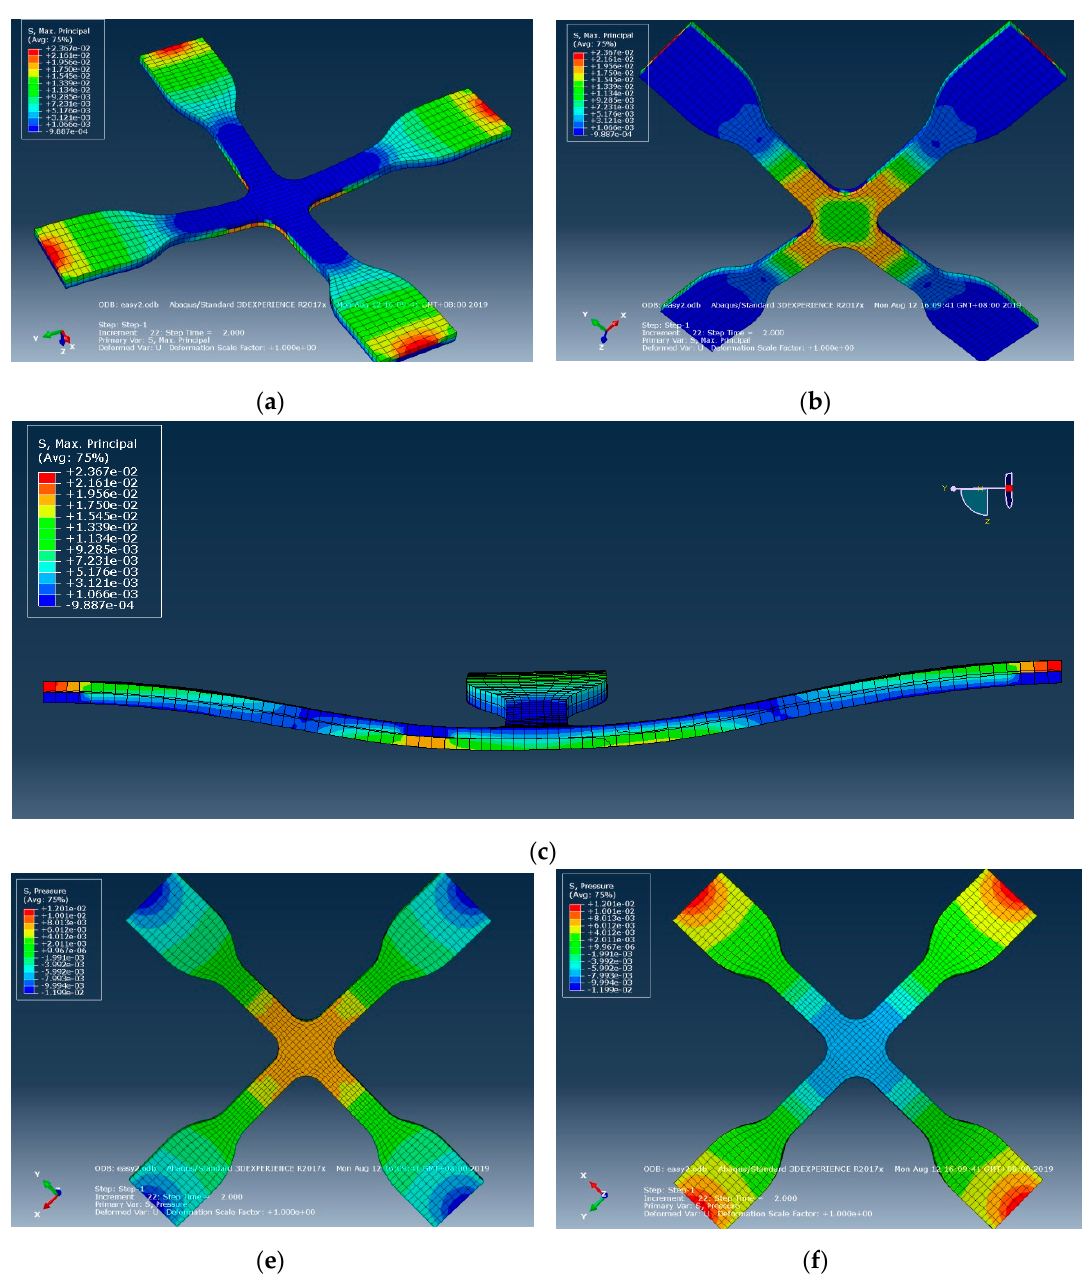
Figure 8. Simulation of force distribution before and after gasbag pressure on cross mold contact stress surface, microstructure surface, and cross section controlled by dynamic tensile. ( a ) Elongation state (Stress surface); ( b ) elongation state (microstructures surface); ( c ) elongation state (cross section); ( d , e ) elongation state with gasbag pressure (stress surface); ( f ) elongation state with gasbag pressure (microstructures surface).